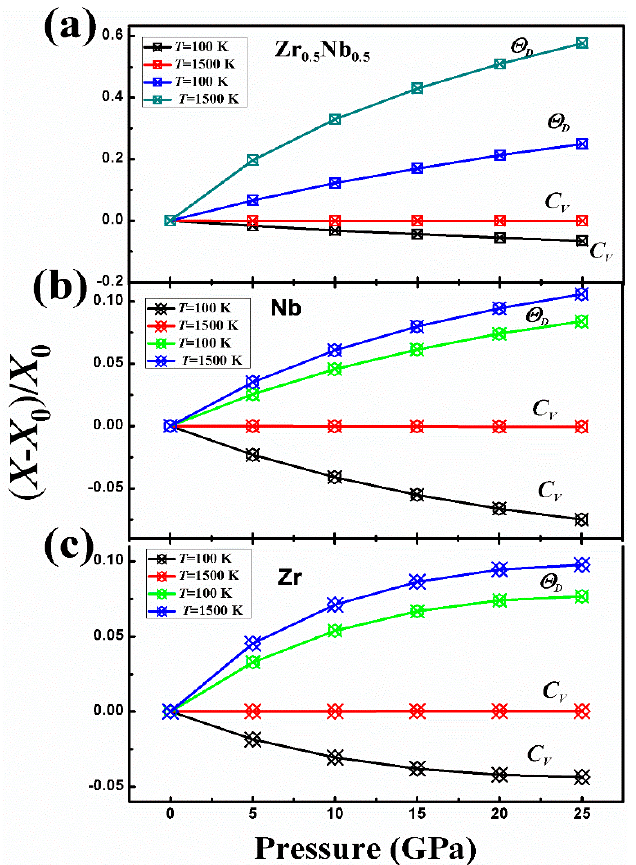
Figure 8. Normalized thermodynamic parameters (( X − X 0 )/ X 0 ) of Zr 0.5 Nb 0.5 as a function pressure at certain temperatures up to ~1500 K ( a ), in comparison those for Nb metal ( b ) and hcp -Zr material ( c ), where X and X 0 are the Debye temperature ( Θ D ) or heat capacity ( C v ) under variously high P-T and zero P-T conditions, respectively.